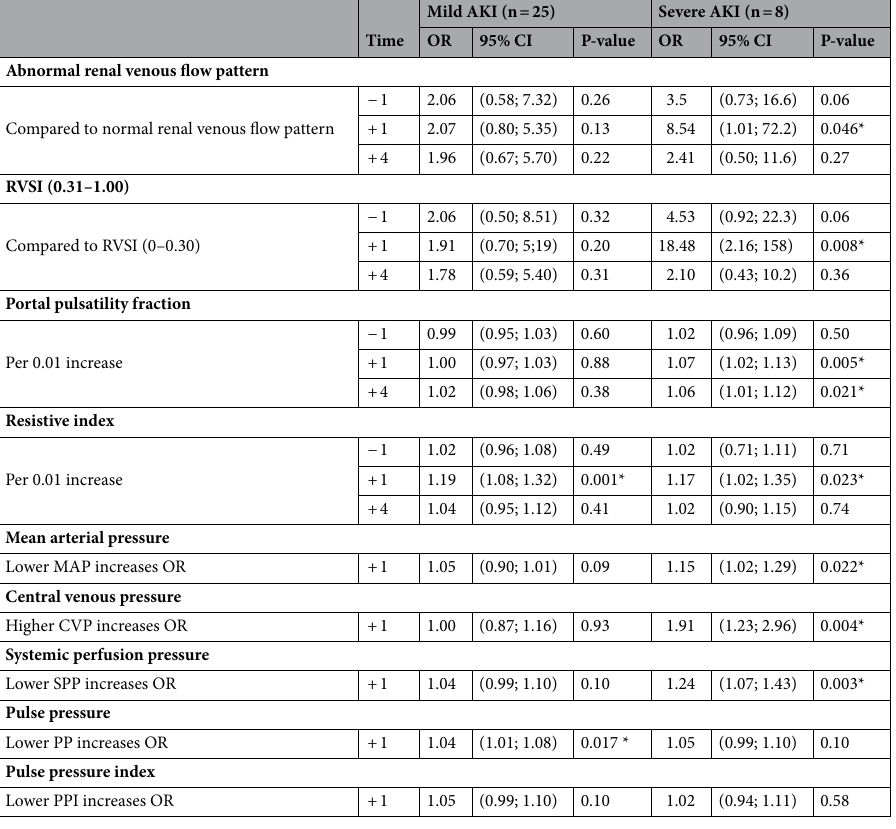
Table 3. Univariate logistic regression. Odds ratio (OR), 95% CI (confidence interval) and P-value for developing mild AKI and severe AKI, respectively after cardiac surgery with no AKI as reference group. The numbers − 1, + 1 and + 4 refer to the time of the ultrasound examination at the day before surgery, the first postoperative day and the fourth postoperative day. Abnormal venous flow pattern and renal venous stasis index (RVSI) are treated as dichotomous variables and resistive index portal pulsatility fraction and hemodynamic values are treated as continuous variables. Higher OR depicts higher risk of mild or severe AKI. No AKI, mild AKI and severe AKI refers to patients who did not develop AKI, developed mild AKI (KDIGO grade 1) or developed severe AKI (KDIGO2 + 3) within the first four postoperative days. * Indicates statistically significant difference (P <